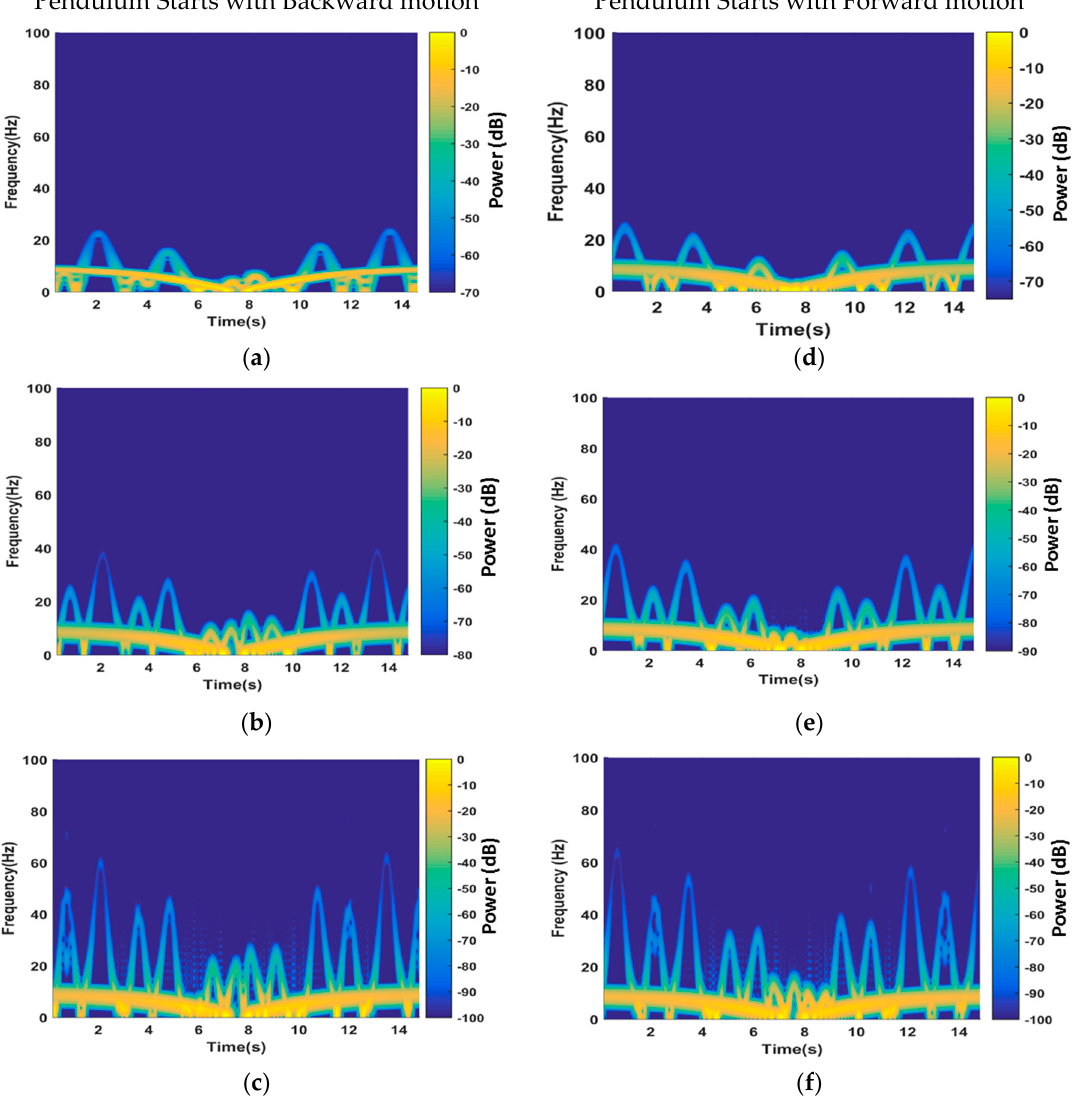
Figure 6. Simulation results for spectrogram of Doppler signature created from one swinging forward-shifted pendulum with: ( a ) θ 0 = 20 ◦ ; ( b ) θ 0 = 40 ◦ ; and ( c ) θ 0 = 70 ◦ ; and Backward-shifted pendulum with: ( d ) θ 0 = 20 ◦ ; ( e ) θ 0 = 40 ◦ ; and ( f ) θ 0 = 70 ◦